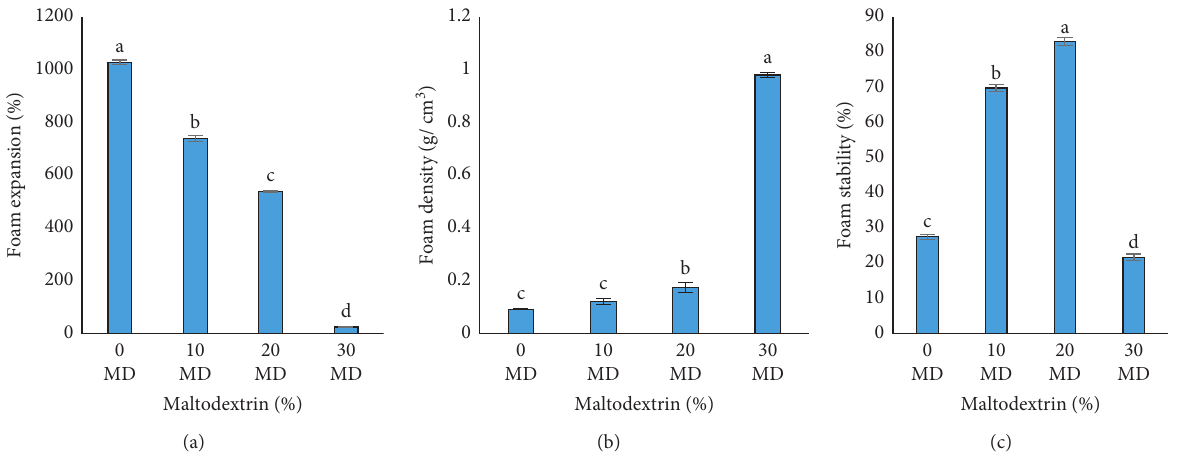
Figure 1: The effect of maltodextrin concentration on: (a) foam expansion (%), (b) foam density (g/cm 3 ), and (c) foam stability (%) of the red beetroot extract-based foams. Mean ± standard deviation ( n � 3). Different small letters on each column show significant statistical Table 1: Physical properties of the foam-mat-dried instant beverage powders based on red beetroot extract. Drying method MD (%) Moisture content (%) Carr’s index (%)